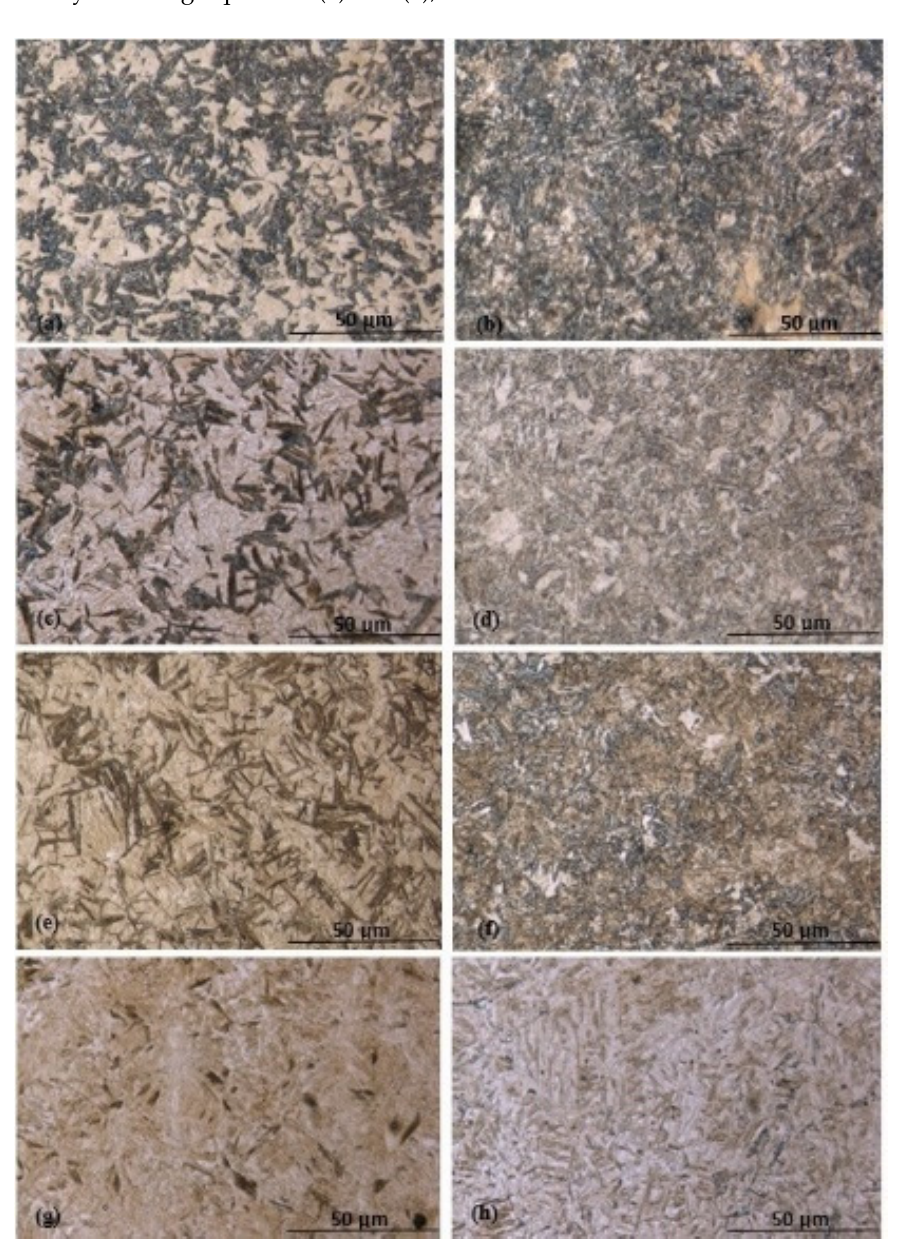
Figure 2. Various bainite observed in the experiments under LOM (500 × ): ( a , b ) UB at 427 ◦ C, 30 s–900 s; ( c , d ) UB/LB mix at 371 ◦ C, 30 s–600 s ( e , f ) LB at 343 ◦ C, 60 s–600 s; ( g , h ) M/LB mix at 288 ◦ C, 60 s–600